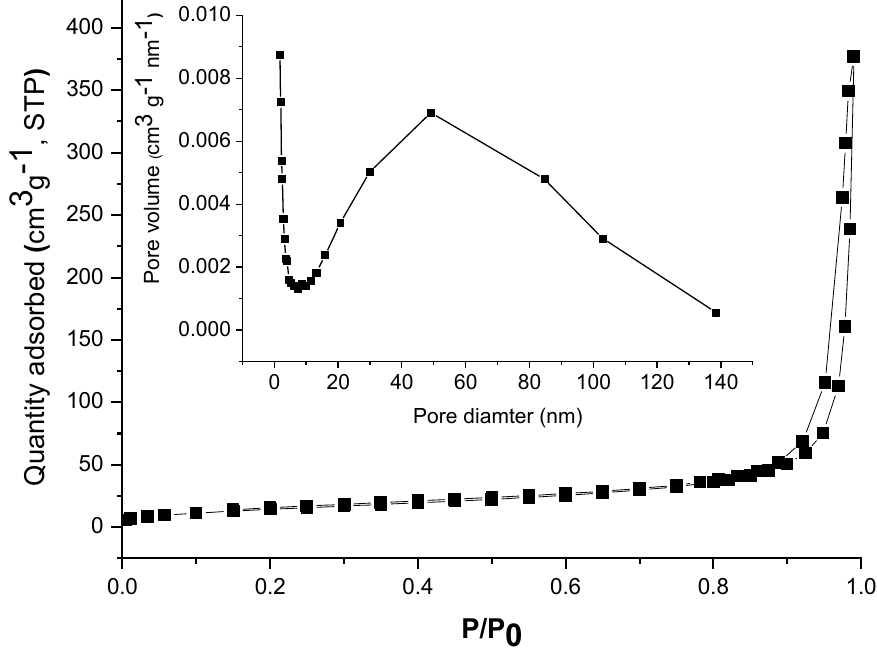
Figure 5. N 2 adsorption–desorption isotherm of TiO 2 –Au and the corresponding pore size distribution (inset).